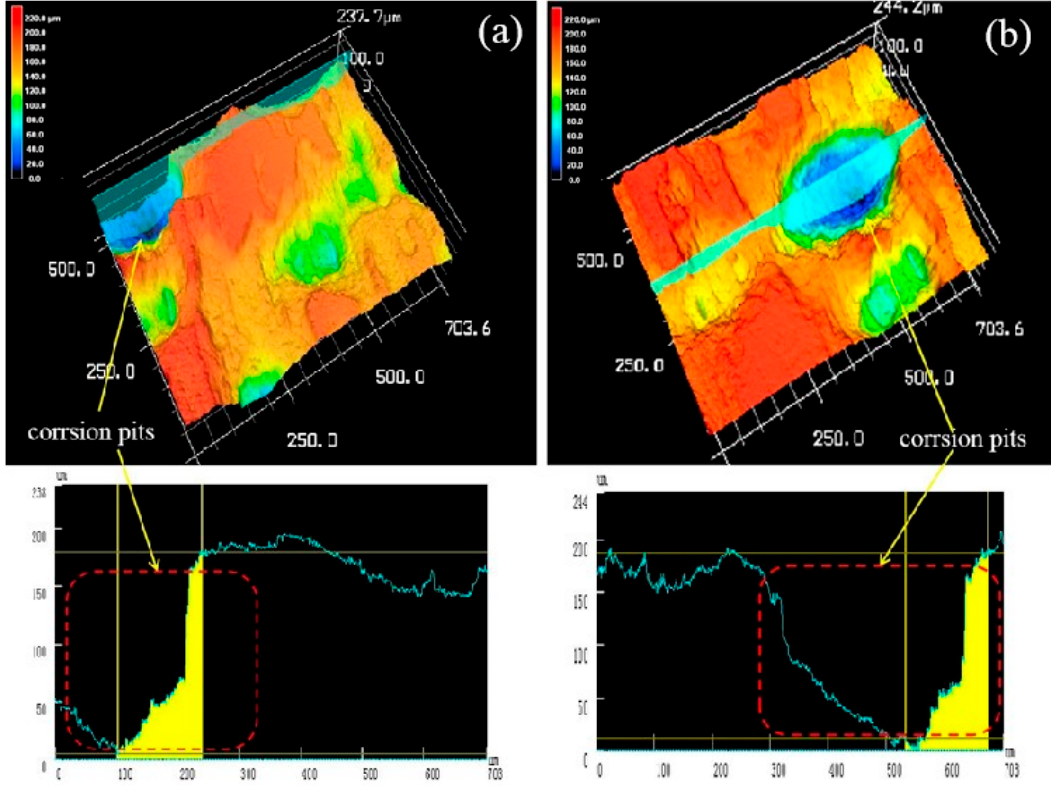
Figure 14. Both ( a ) and ( b ) were three-dimensional corrosion morphology of extruded alloy (250 ◦ C) Figure 14. Both (a) and (b) were three ‐ dimensional corrosion morphology of extruded alloy (250 °C) after corrosion product removal. after corrosion product removal.